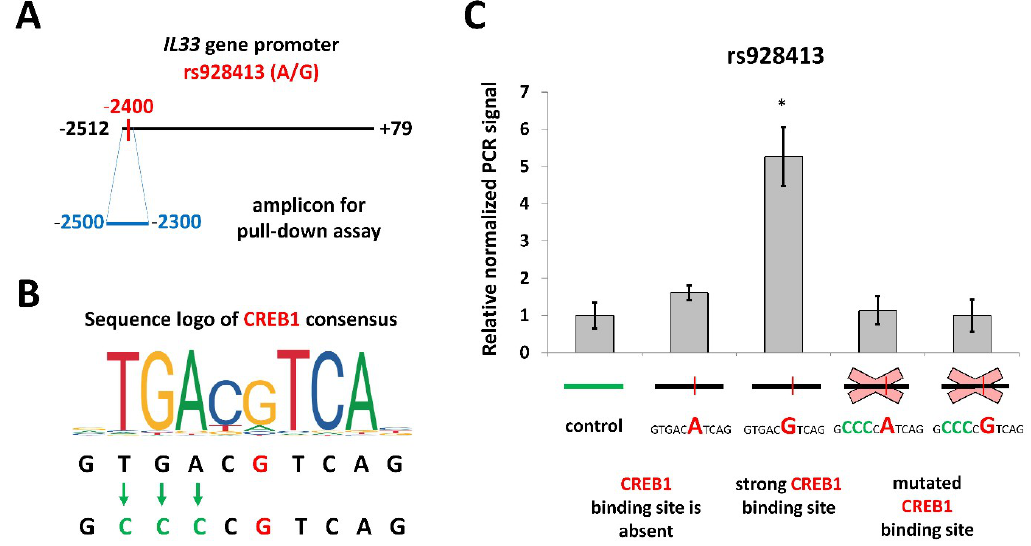
Figure 2. Rs928413(G) is associated with CREB1 binding. ( A ) Schematic illustration of rs928413 location in IL33 promoter and the amplicon used for the pull-down assay. ( B ) Position weight matrix of CREB1-binding site and schematic illustration of its mutagenesis. Green arrows indicate nucleotides changes. ( C ) Efficiency of CREB1 binding to different variants of IL33 promoter (rs928413 variants shown in red color) as estimated by pull-down assay using nuclear extracts from NCIH-196 cells. Data was normalized to control amplicon after subtraction of the background signal (see Section 4). The result of five independent experiments is represented. * p < 0.01.